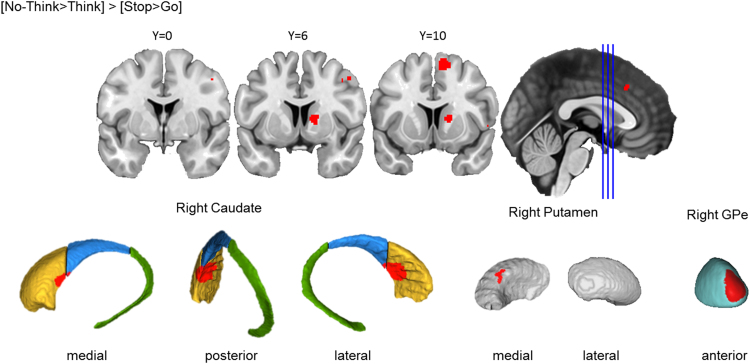
Spatial Co-localisation of memory inhibition and action cancellation in basal ganglia subregions. Top row: Clusters are presented on coronal slices of a high-resolution MNI atlas. Reference lines for the coronal slices are presented in the sagittal plane. Bottom row: Clusters are displayed on high-resolution parcellations of the caudate, putamen, and external globus pallidus (GPe). All clusters are thresholded using cluster-level inference (p<.05, uncorrected p<.001, threshold permutations=1000).